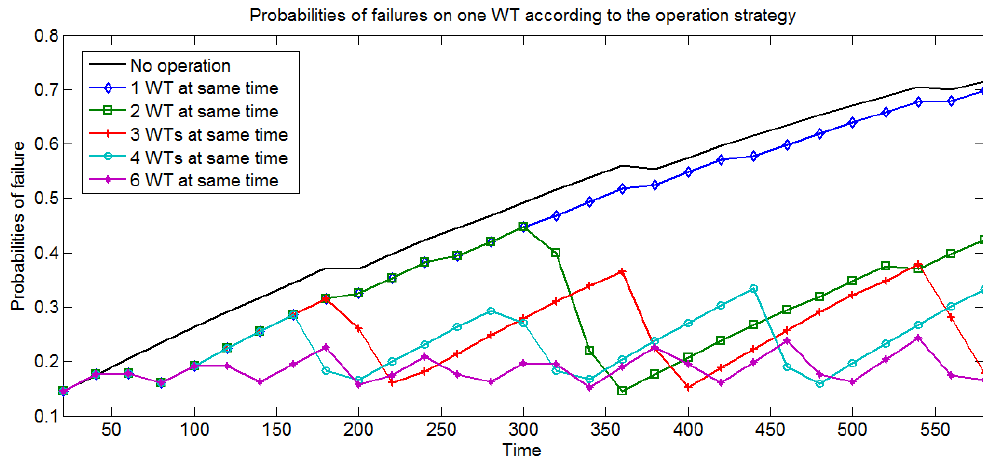
Figure 7. Probabilities of failure of a WT.